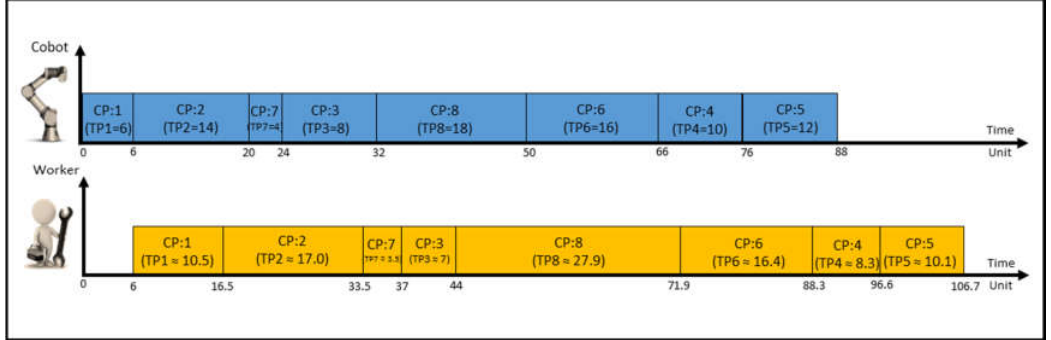
Figure 9. Gantt chart of the case-study scheduling.